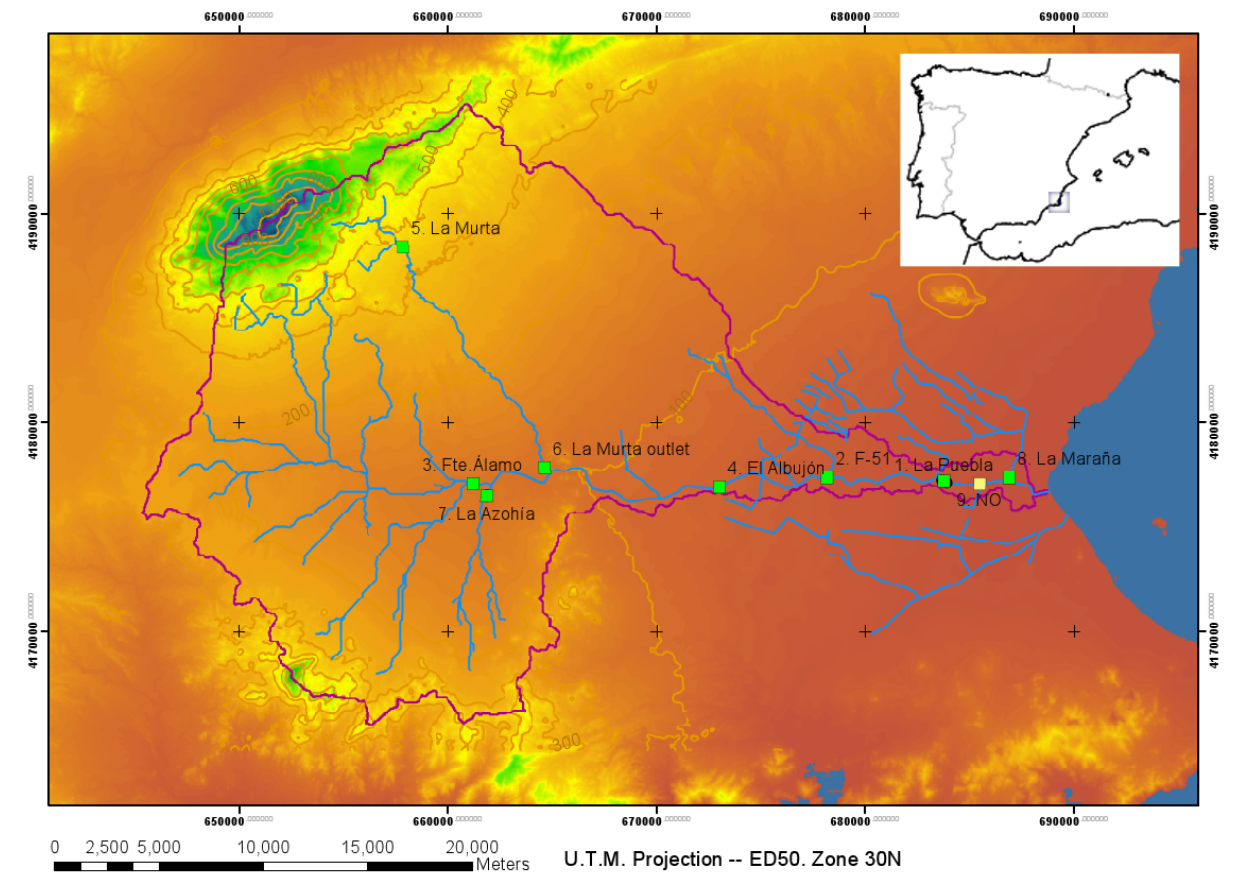
Figure 1. Deployment scenario. The embedded image shows the location of the Rambla del Albuj´on watershed at the Southeast of the Iberian Peninsula. The violet line describes the watershed boundary drawn on a digital terrain model (DTM). Within the watershed, the main channel network is shown in blue, and labeled squares indicate deployed gauge